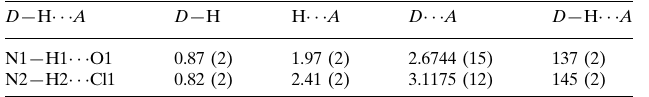
Hydrogen-bond geometry (A˚ , (cid:1)